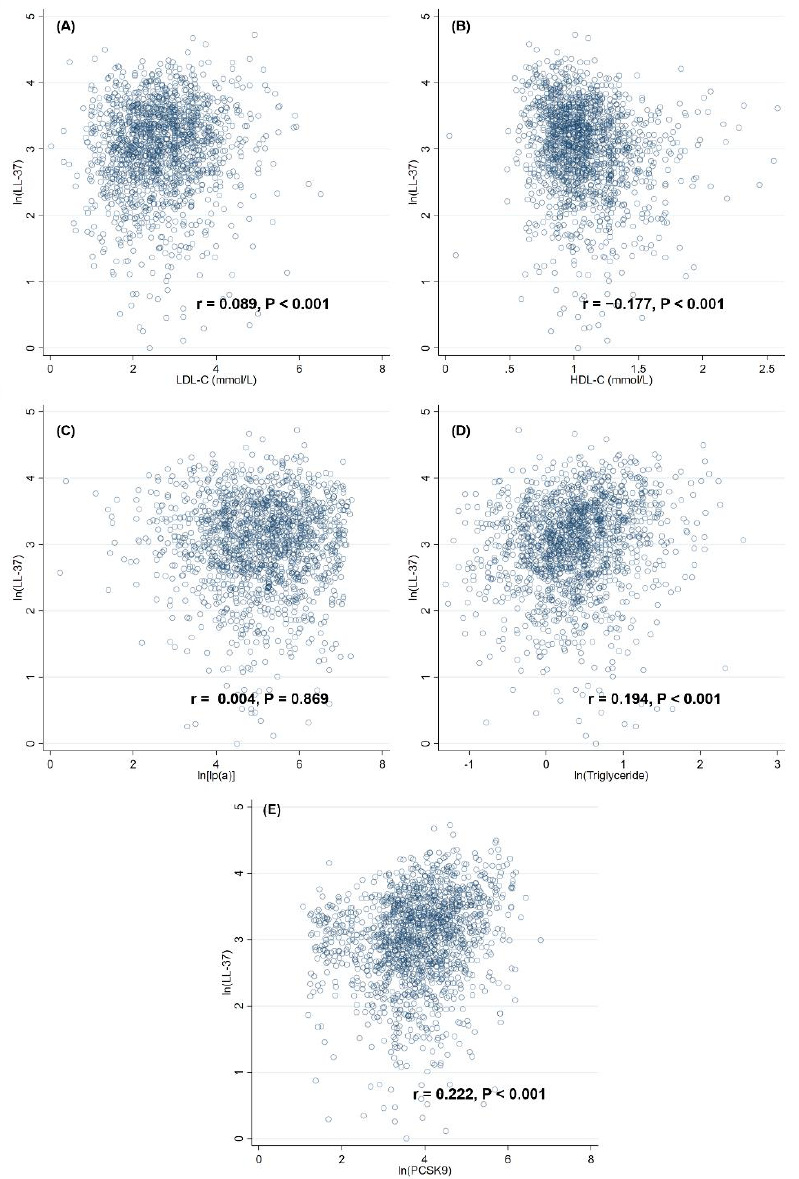
Figure 1. Study flow chart. AMI = acute myocardial infarction; HDL-C = high-density lipoprotein cholesterol; LDL-C = low-density lipoprotein cholesterol; lp(a) = lipoprotein(a); PCSK9 = proprotein convertase subtilisin/kexin type 9.